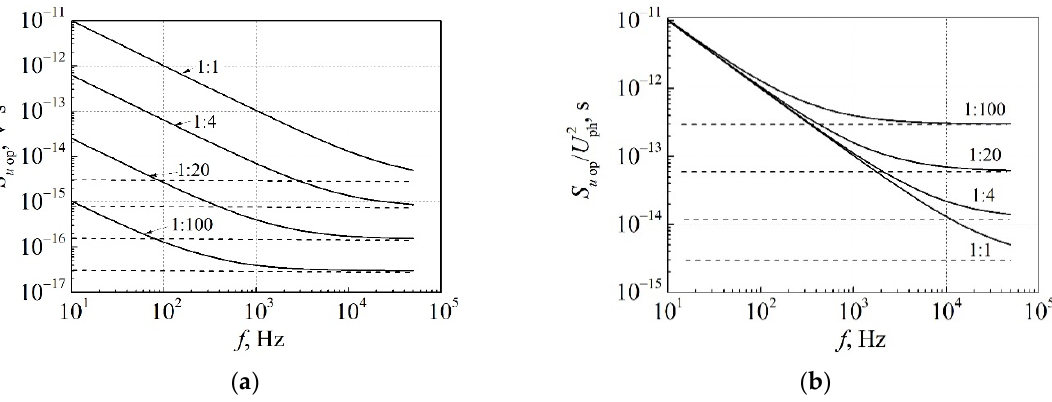
Figure 9. ( a ) The optical noise spectra and ( b ) the relative optical noise spectra at various incident light attenuation ratios at constant LED bias regime ( I LED = 140